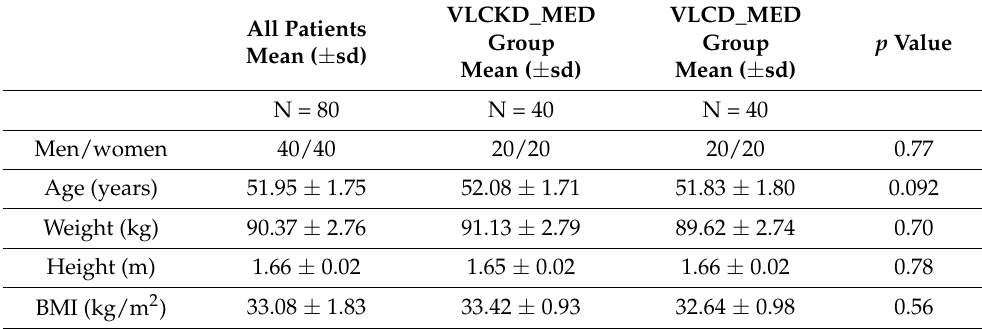
Table 1. Baseline characteristics of patients. All